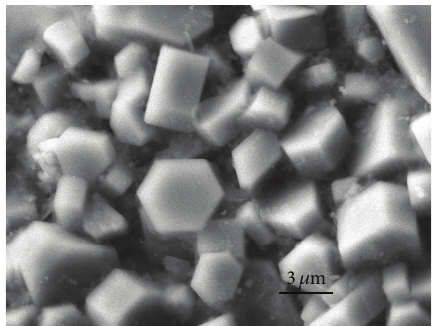
Figure 9: Transgranular cleavage patterns in Cr-Ni-Al alloy